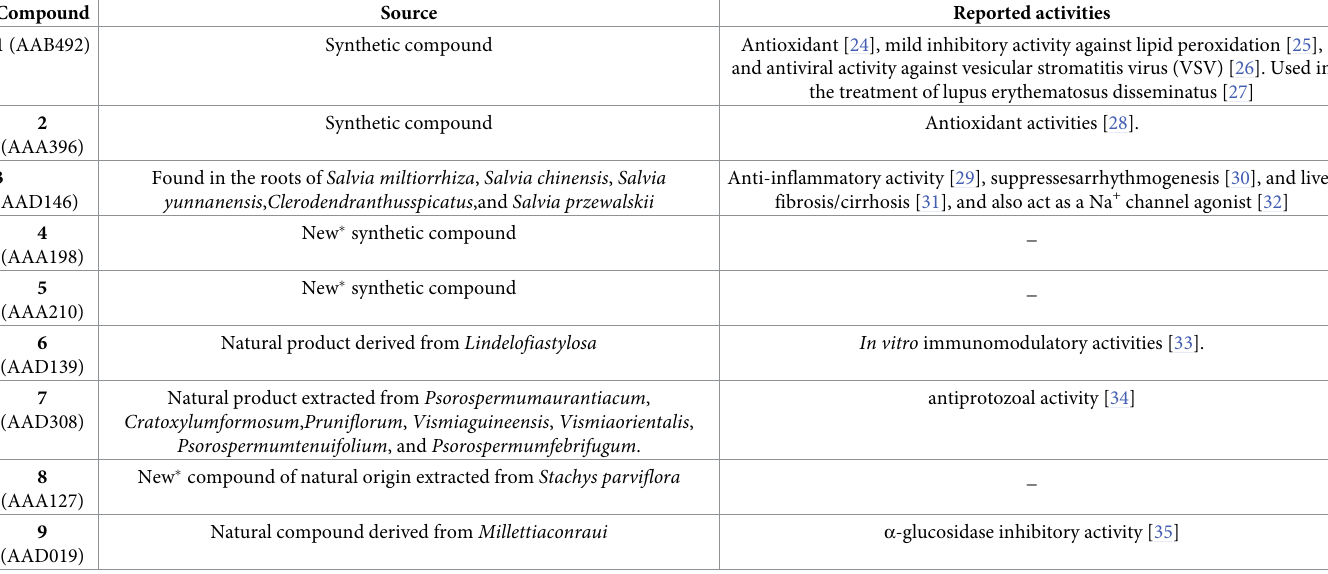
Table 1. Sources of the compounds and reported biological activities of in silico identified ligands of SARS-CoV-2 3CL-pro main proteases. Compound